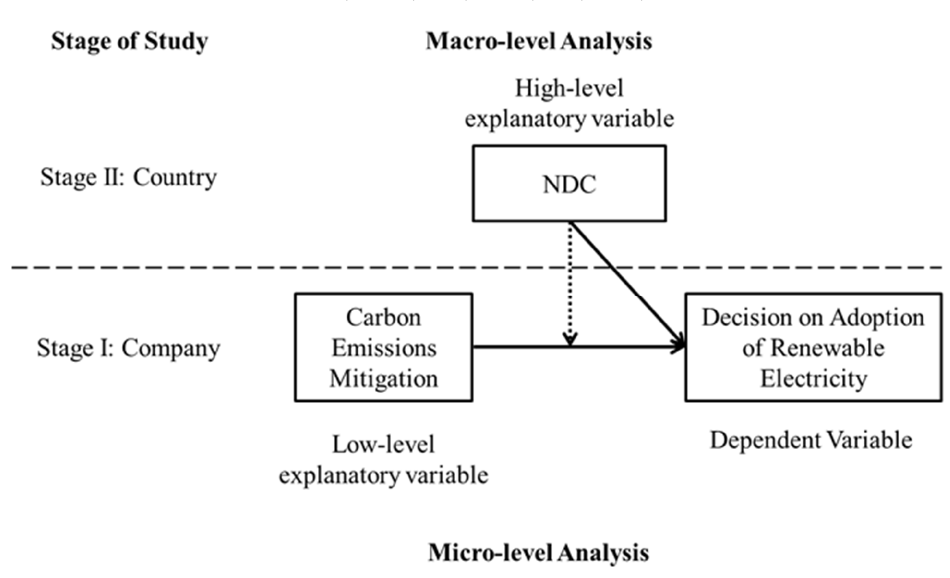
Figure 3. The structure and relationships of the relevant variables in a two-level HLM.